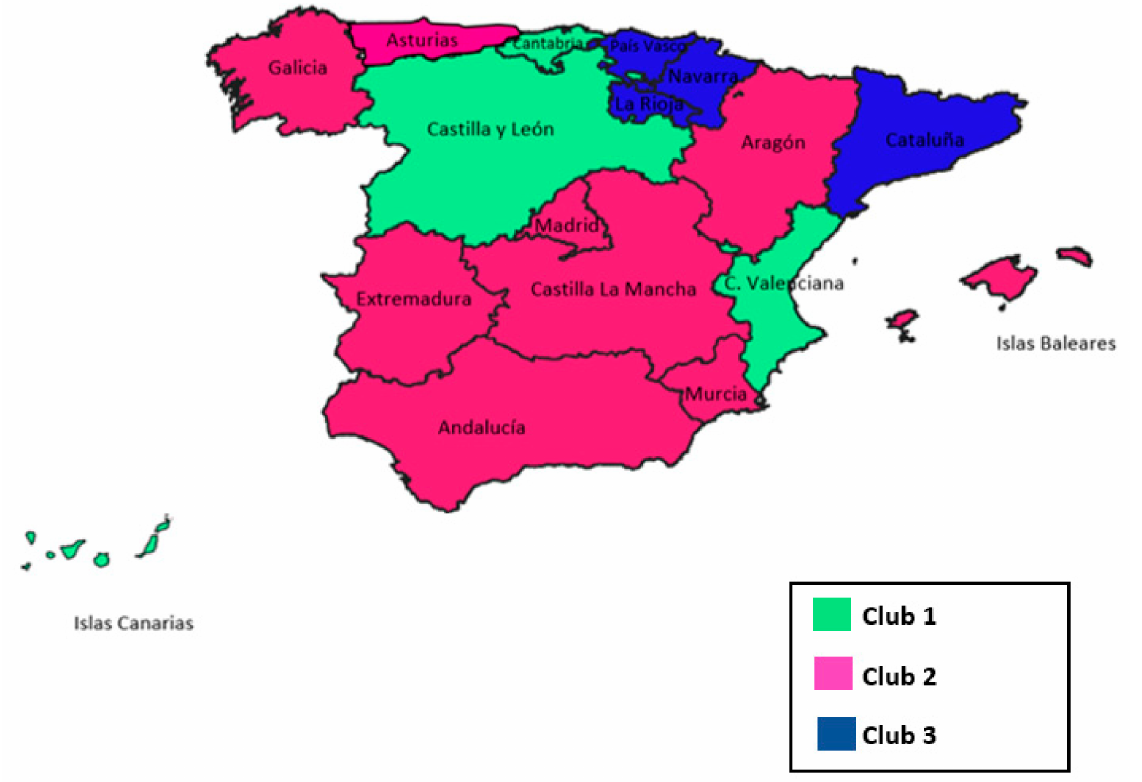
Figure 2. Estimated convergence